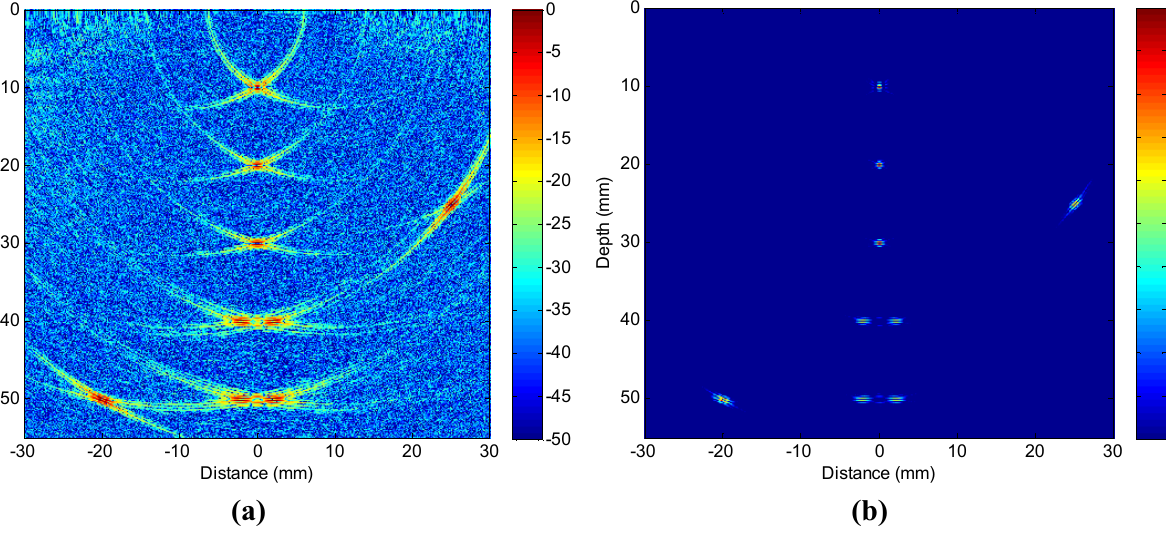
Figure 4. Simulated images with a 50 dB dynamic range obtained with (a) delay-and-sum beamforming, and (b) adaptive beamforming. A single element at array centre transmits and all array elements receive with dynamic focusing at every point in image.